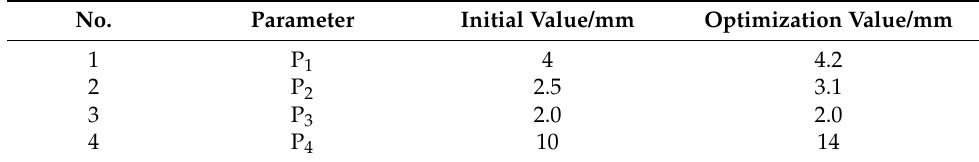
Table 2. Optimal structural parameters.